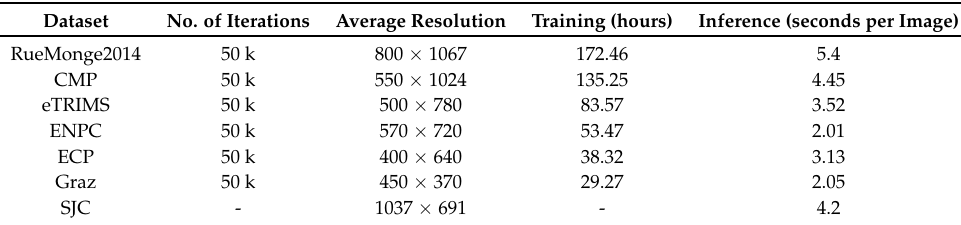
Table 2. Training attributes and performance.